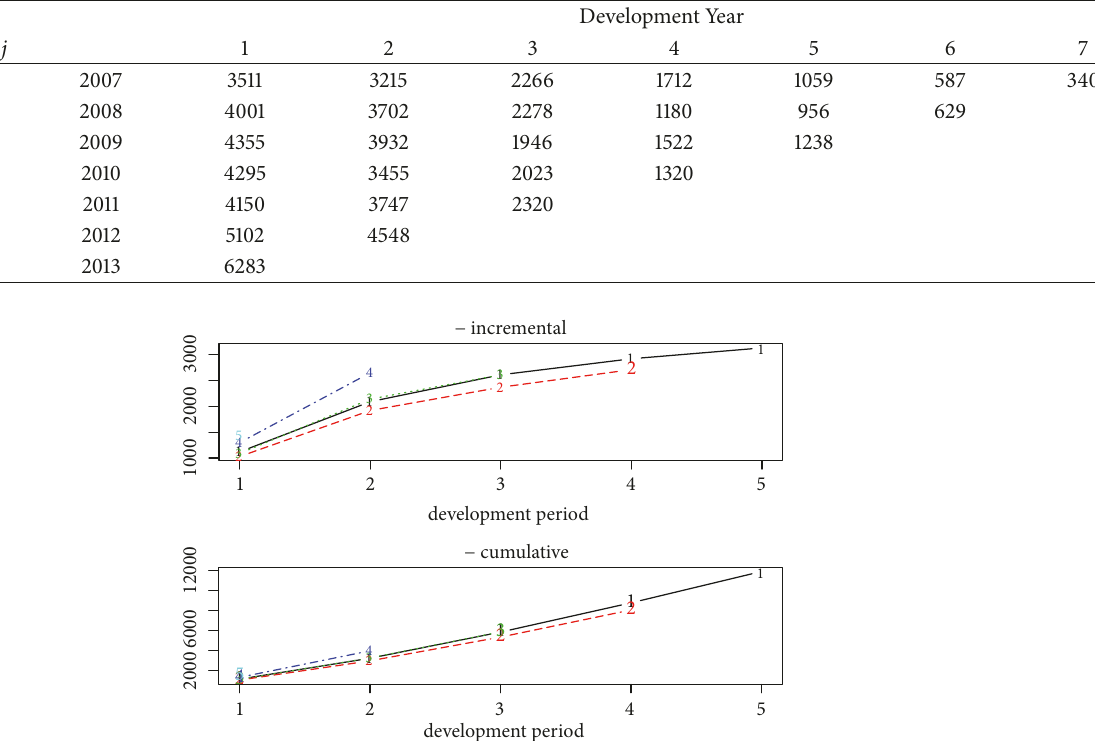
Table 3: Numerical example from [10].